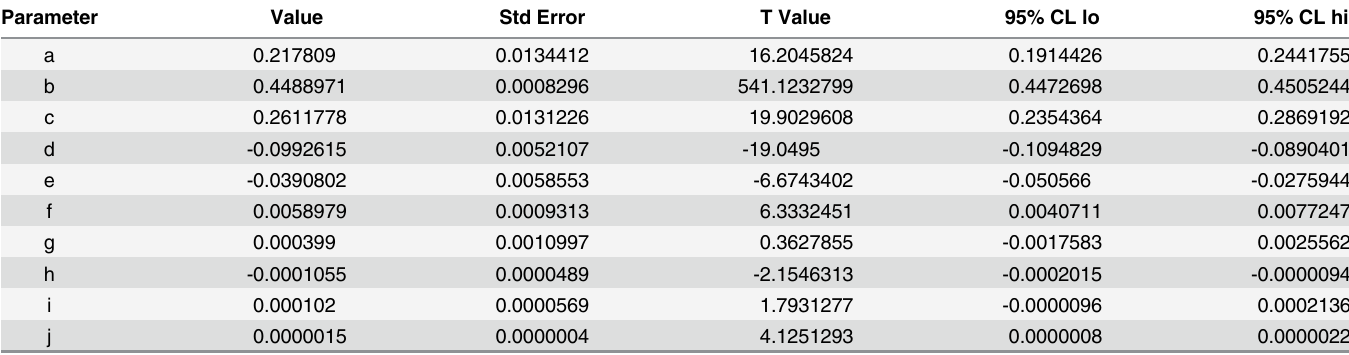
Table 3. Model parameter values. Also given are the standard error and T statistic for the values, and the upper and lower 95% confidence limits for the values. Parameter Value Std Error